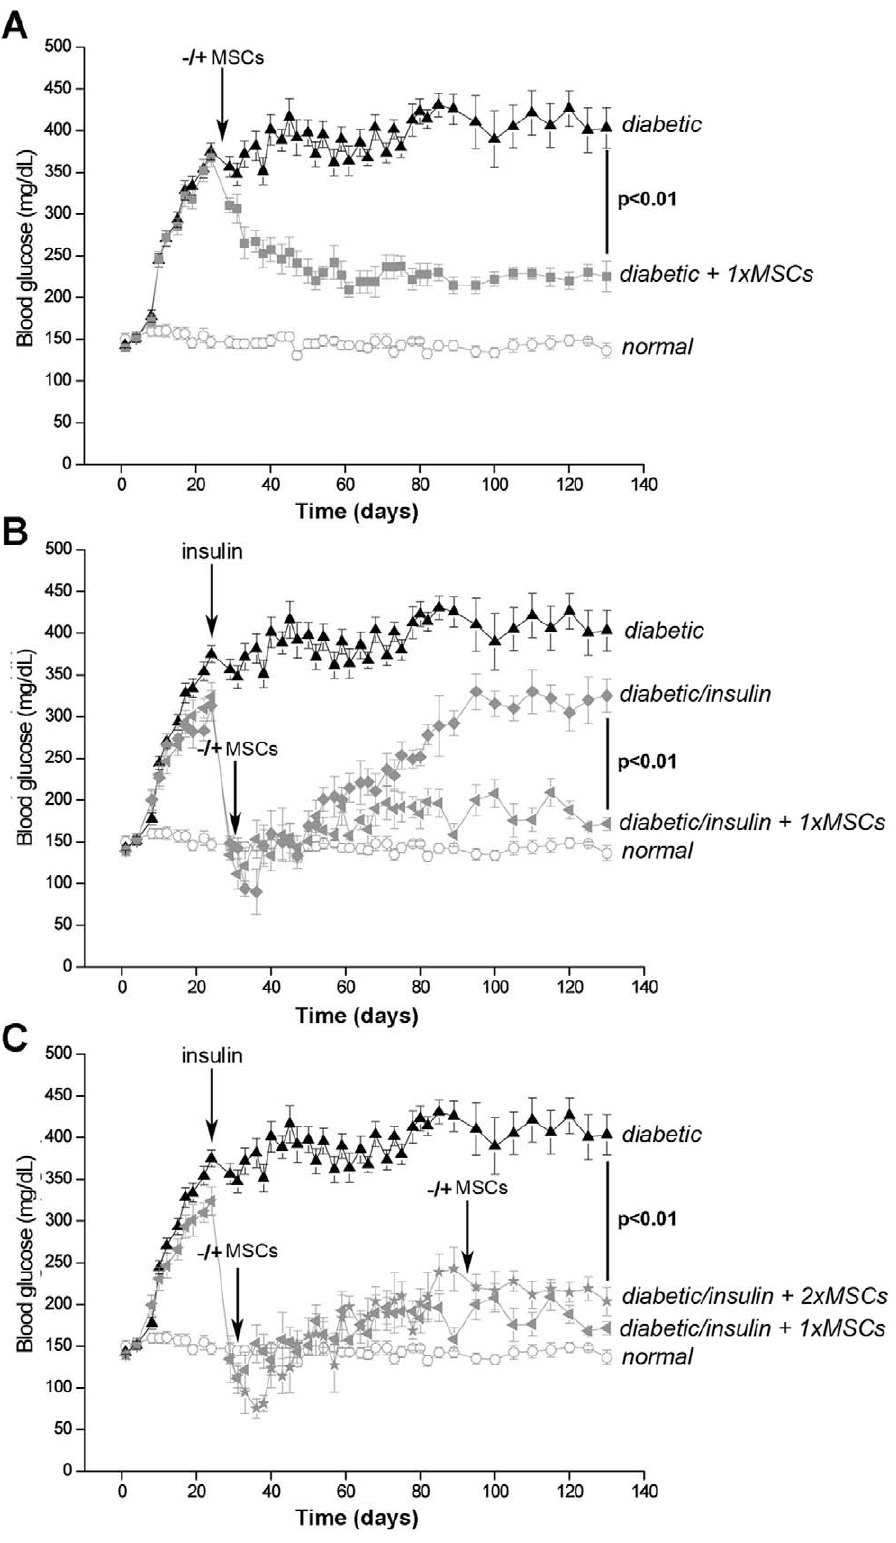
Figure 2. Hyperglycemia reversion in diabetic mice after MSC transplantation. Diabetic mice received or not MSCs (A). Diabetic mice received or not insulin prophylaxis and/or MSCs (B). Diabetic mice received or not insulin prophylaxis and one or two doses of MSCs (C). Blood glucose levels were determined every three days in alert nonfasted animals. Data correspond to mean 6 s.e.m. for 9 animals per experimental group. Only statistical significant values among diabetic mice are shown.